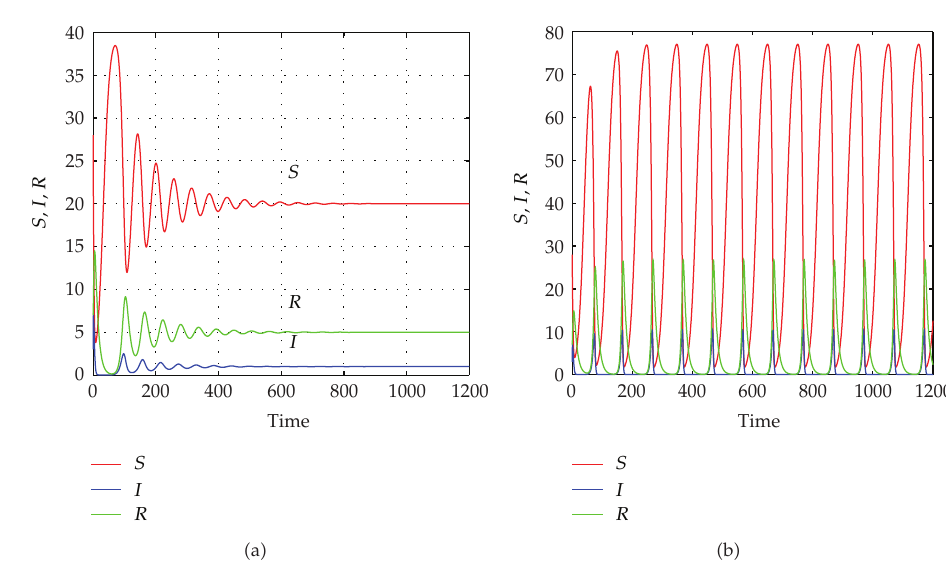
Figure 1: Solution of delayed SIR model (cid:3) 3.2 (cid:6) , when r (cid:7) 0 . 1, β (cid:7) 0 . 1, σ (cid:7) 0 . 05, a (cid:7) 0 . 5, α (cid:7) 0 . 5, δ (cid:7) 0 . 1, and time-lag τ (cid:7) 1 when S ∗ (cid:7) 20, K (cid:7) 40, R 0 (cid:7) 2, R c (cid:7) 2 . 33 (cid:3) a (cid:6) and K (cid:7) 80, R 0 (cid:7) 4, R c (cid:7) 2 . 33 (cid:3) b (cid:6) that display periodic outbreak of the disease. We get a stable solution when 1 < R 0 ≤ R c and a stable periodic solution when R 0 > R c